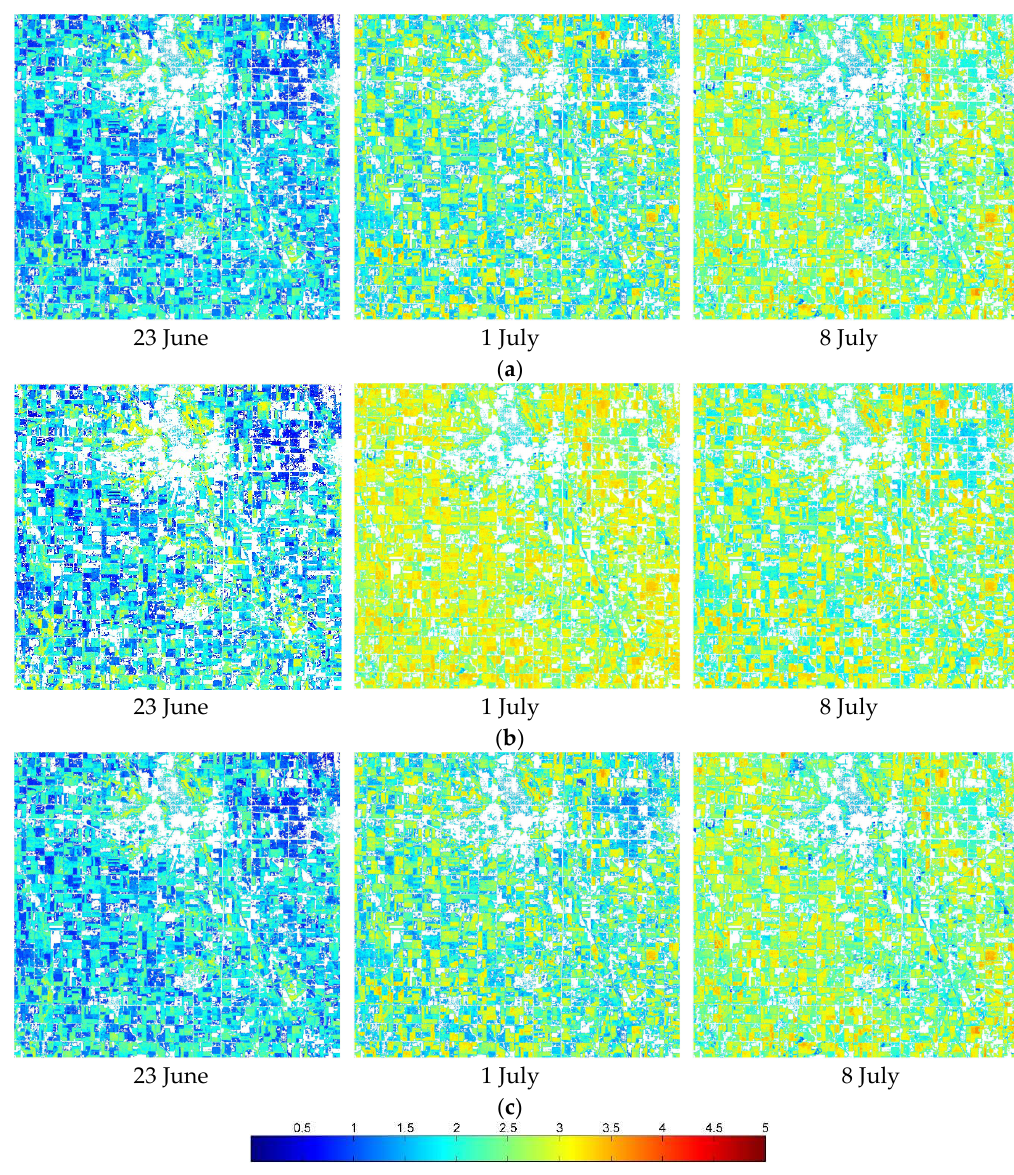
Figure 8. The LAI inversion in time series at the SMEX02 site (23 June, 1 July, and 8 July): ( a ) the results of dataset A1; ( b ) the results of dataset A2; ( c ) the results of dataset